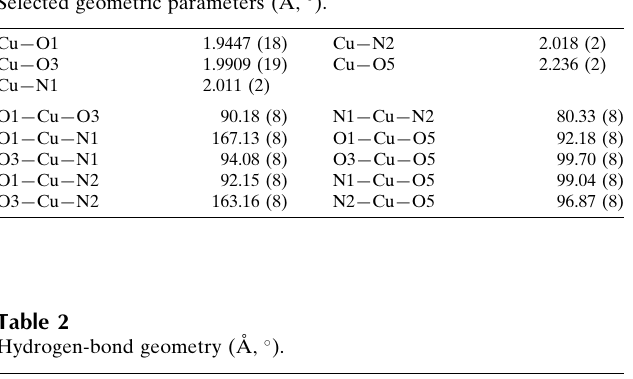
Selected geometric parameters (A˚ , (cid:2) ).